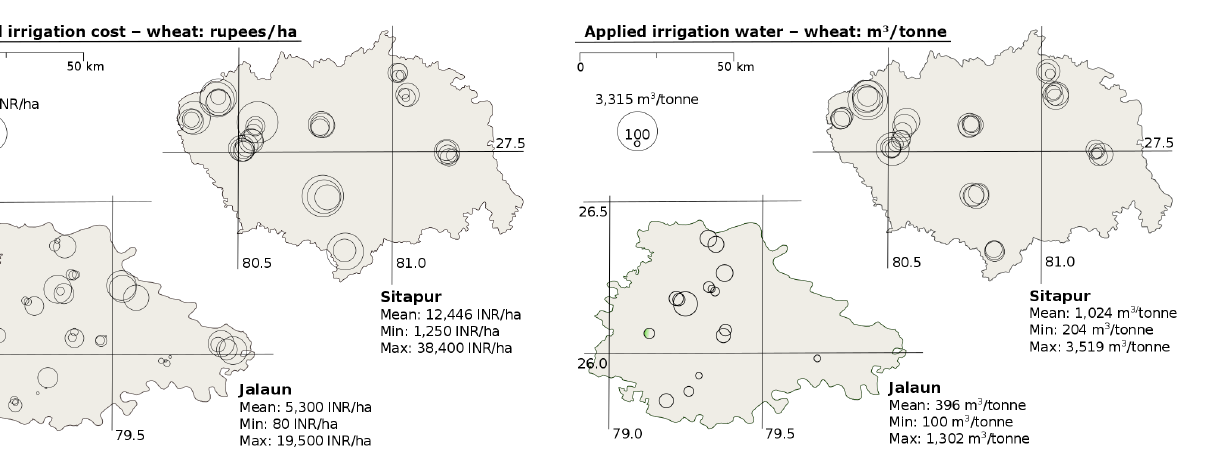
Figure 3. Spatial variations in the annual price paid for the irrigation of wheat by farmers in Jalaun and Sitapur, Uttar Pradesh, northern India.